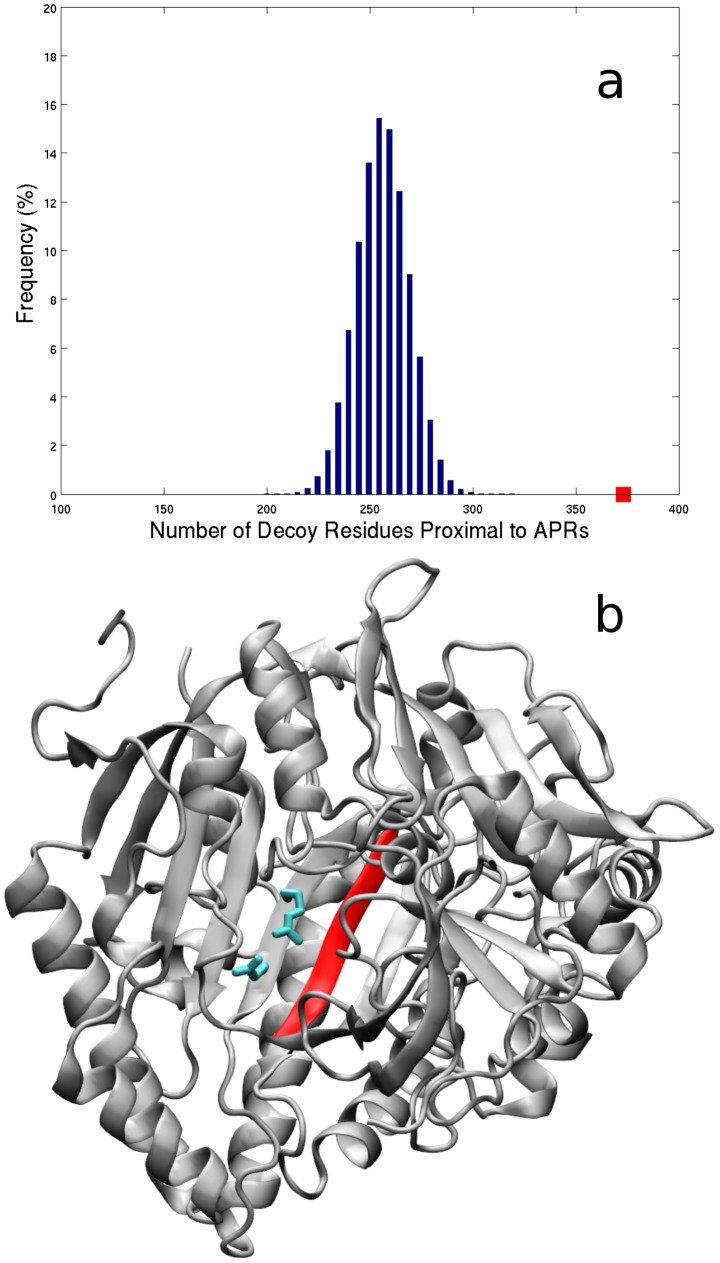
Catalytic residues are in contact with APRs more often than expected by random chance.(a) Histogram shows the number of residues (out of a maximum of 961) that are in contact with TANGO predicted APRs from 1,000,000 decoy catalytic residue lists (see Methods). X-axis shows the number of residues and Y-axis shows the frequency. There are 373 true catalytic residues in structural contact (using a distance cut-off of 4.5 Å) with the TANGO predicted APRs, shown by a red square along the X-axis. (b) Structural proximity between catalytic residues and a TANGO predicted APR in Cholesterol oxidase from B. Sterolicum is shown. Catalytic residues represented by cyan colored sticks are in contact with APRs represented by red colored ribbons. The image was made using chain A in PDB entry 1I19. Note, only structurally proximal catalytic residues and one APR are shown for simplicity.